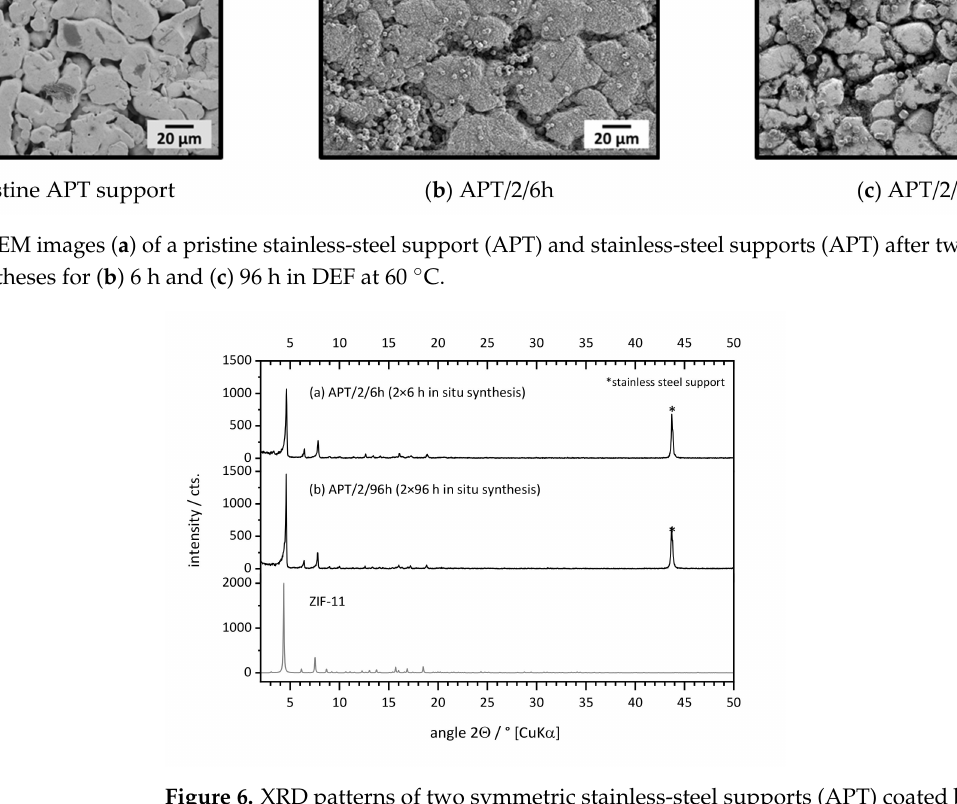
Figure 6. XRD patterns of two symmetric stainless-steel supports (APT) coated by two consecutive in situ syntheses in DEF at 60 ◦ C for ( a ) 2 × 6 h and (b) 2 × 96 h, as well as PXRD reference pattern of ZIF-11.